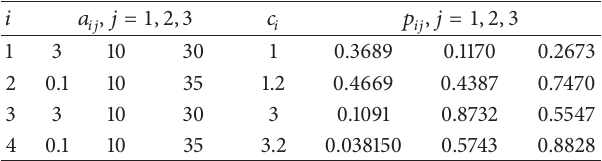
Table 8: Coefficients of function 𝑓 19